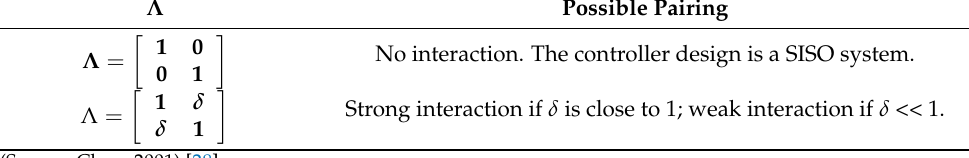
Table 5. Quick summaries of several